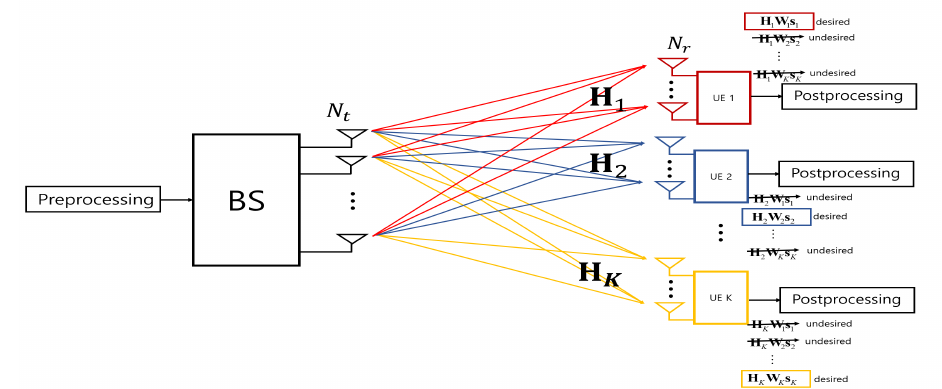
Figure 4. The downlink MU-MIMO broadcasting model.